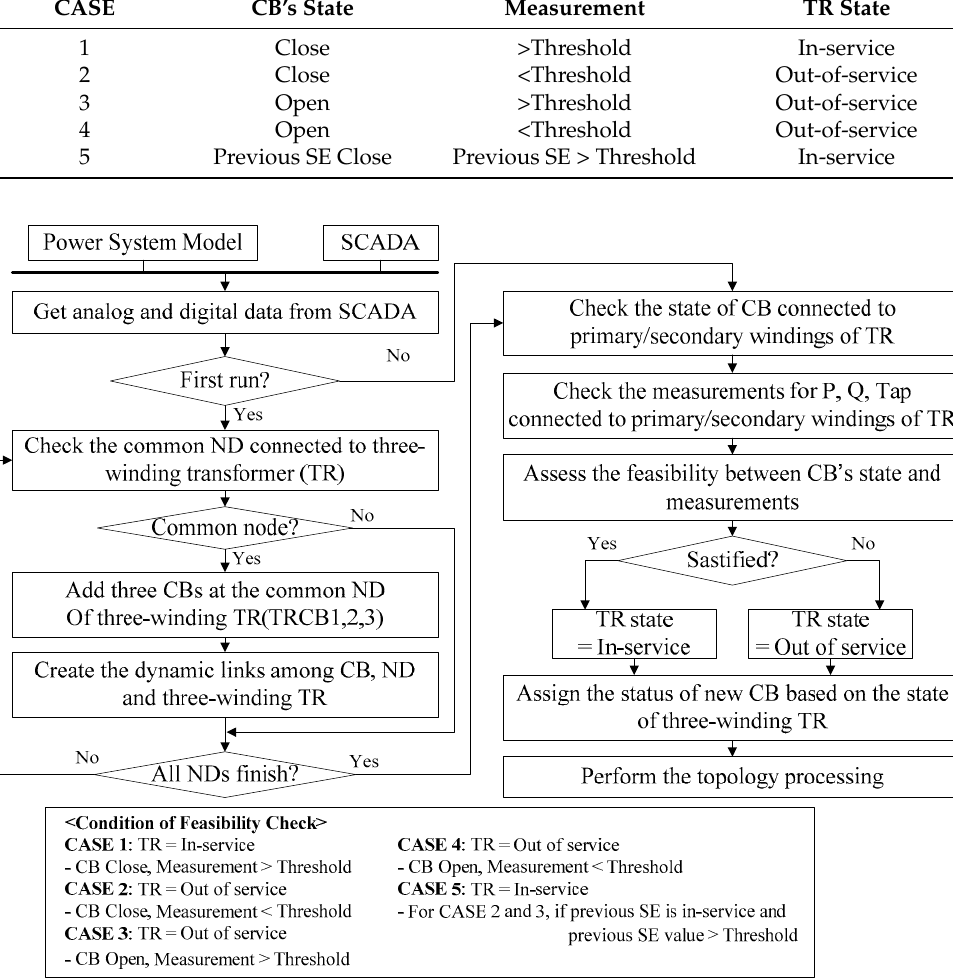
Figure 6. Flowchart of the topology error processing associated with transformer.